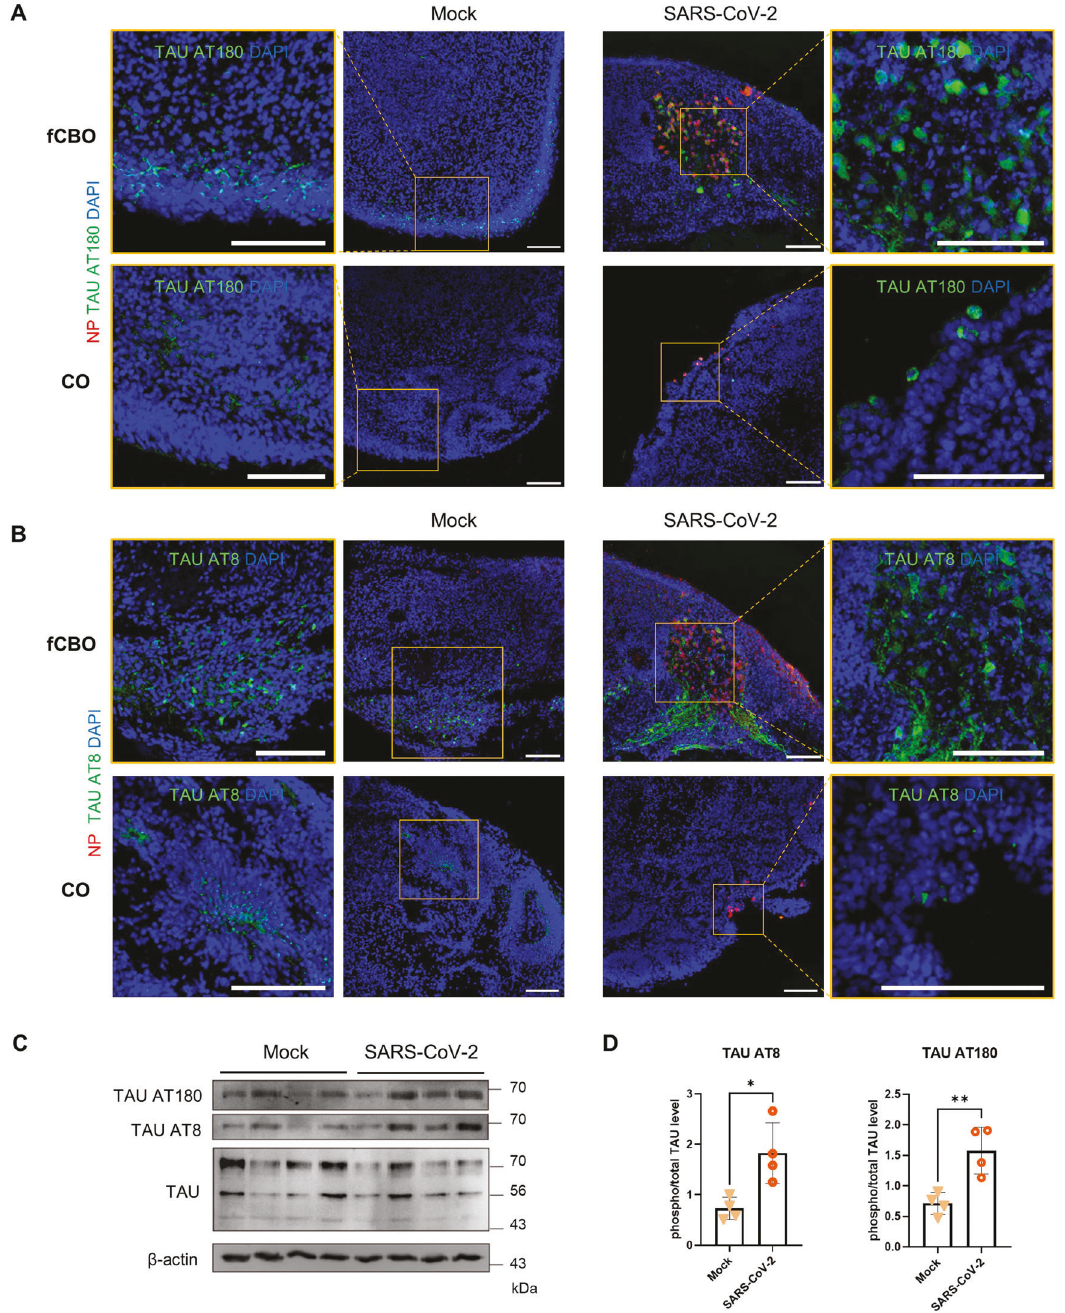
Fig. 4 SARS-CoV-2 infected fused cortical-blood vessel organoids expressed hyperphosphorylated tau. A, B Immunostaining of SARS-CoV- 2 or mock infected fCBOs and COs for NP and tau phosphorylation marker AT180 (pT231Tau) ( A ) and AT8 (pS202T205Tau) ( B ). Scale bars = 100 μ m. C Western blot of SARS-CoV-2 or mock infected fCBOs for AT180, AT8, TAU and the loading control β -actin. D Phospho/total TAU protein levels in SARS-CoV-2 or mock infected fCBOs for AT180 and AT8 ( n = 4). Values represent mean with individual data points plotted. Error bars are SEM of the mean. * p < 0.05, ** p < 0.01, *** p < 0.001 by unpaired two-sided t -test.